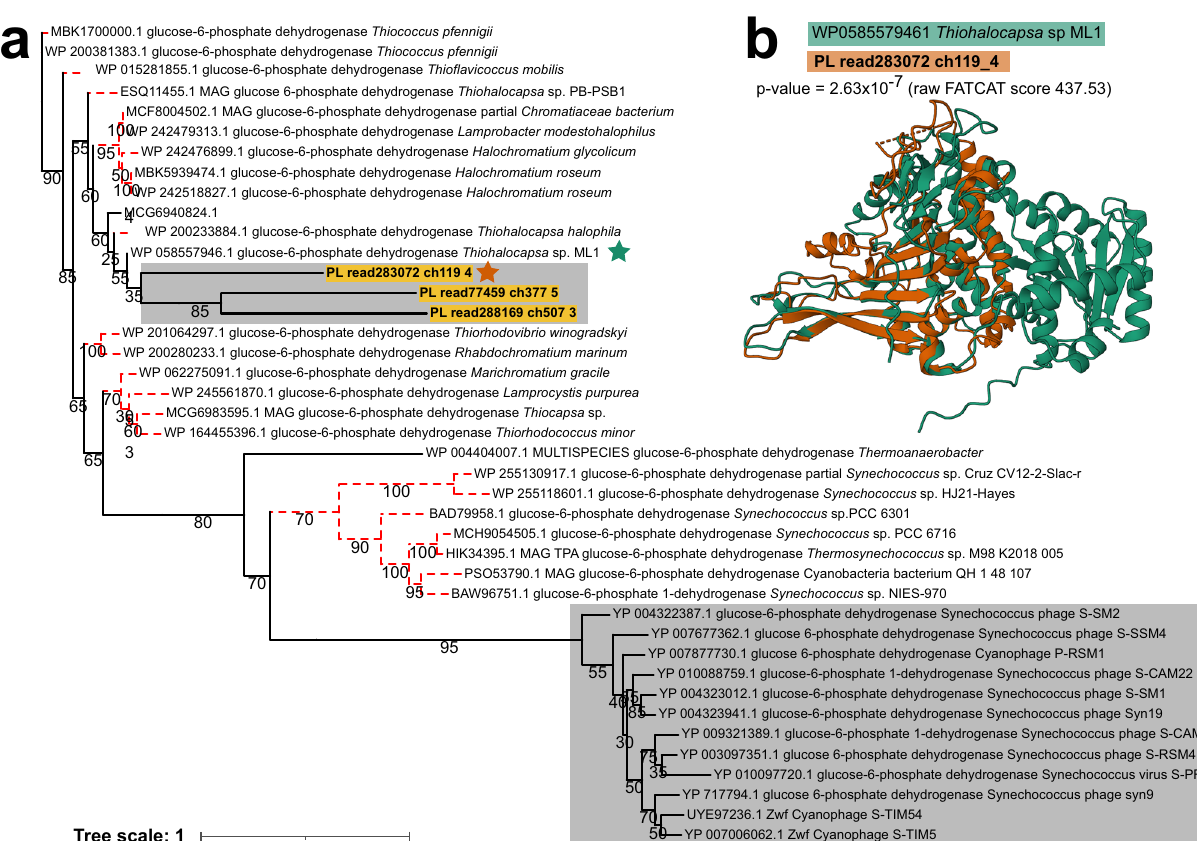
Fig. 4 Relationship between glucose-6-phosphate dehydrogenase from phage genomes identi fi ed in this study and RefSeq non-redundant phage and bacterial proteins. a Maximum-likelihood phylogeny of 41 glucose-6-phosphate dehydrogenase amino acid sequences (G6PD). Red dotted branches indicate bacterial proteins and grey boxes highlight phage proteins. b the superimposed protein structure is the result of a pairwise comparison of G6PD proteins from Thiohalocapsa sp. ML1 (green) and Poison Lake phage read283072 (orange). Folded proteins are denoted by a star on the phylogenetic tree with the aforementioned colors, and p -value of the alignment and raw FATCAT score are reported within the fi